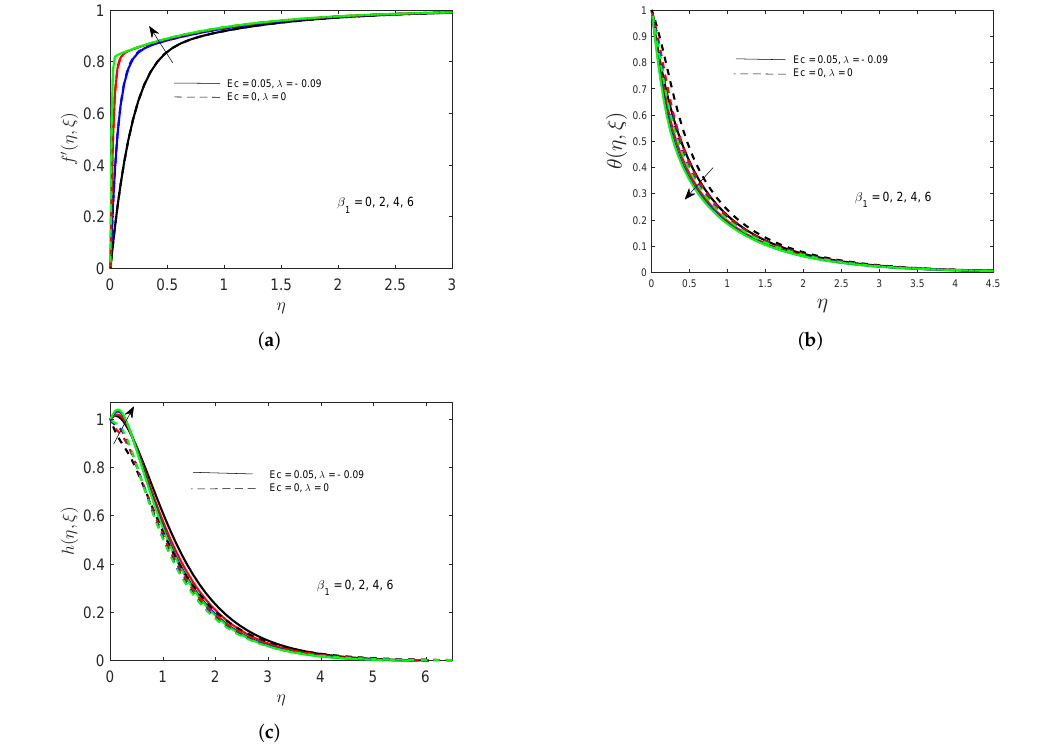
Figure 4. ( a ) Velocity; ( b ) temperature, and ( c ) concentration profiles for different values of the viscosity